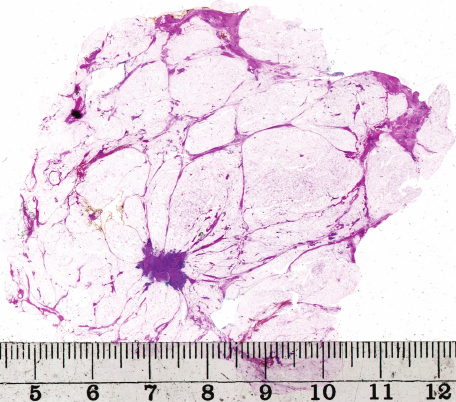
Figure 1: Large-format histology section showing a unifocal breast carcinoma.